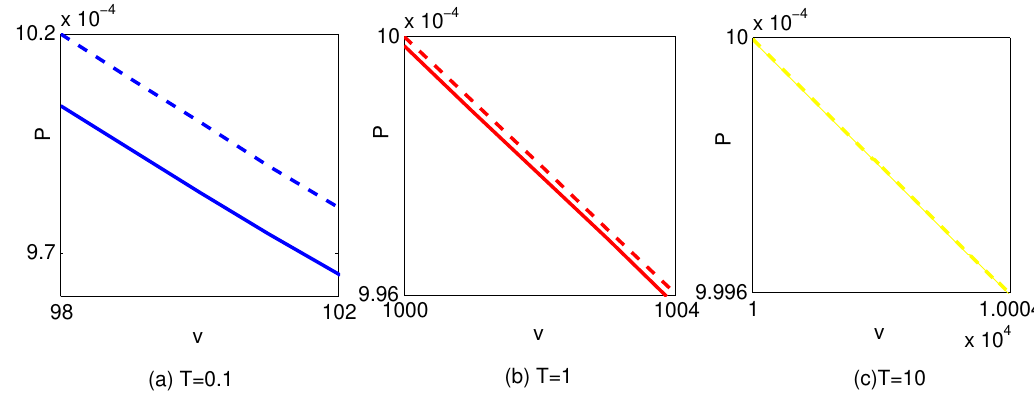
Figure 3 . The equations of state of the Schwarzschild-AdS black hole and the ideal gas at the same temperatures taken in figure 2. In each subfigure, the solid curve represents the equation of state of the Schwarzschild-AdS black hole, and the dashed curve represents that of the ideal